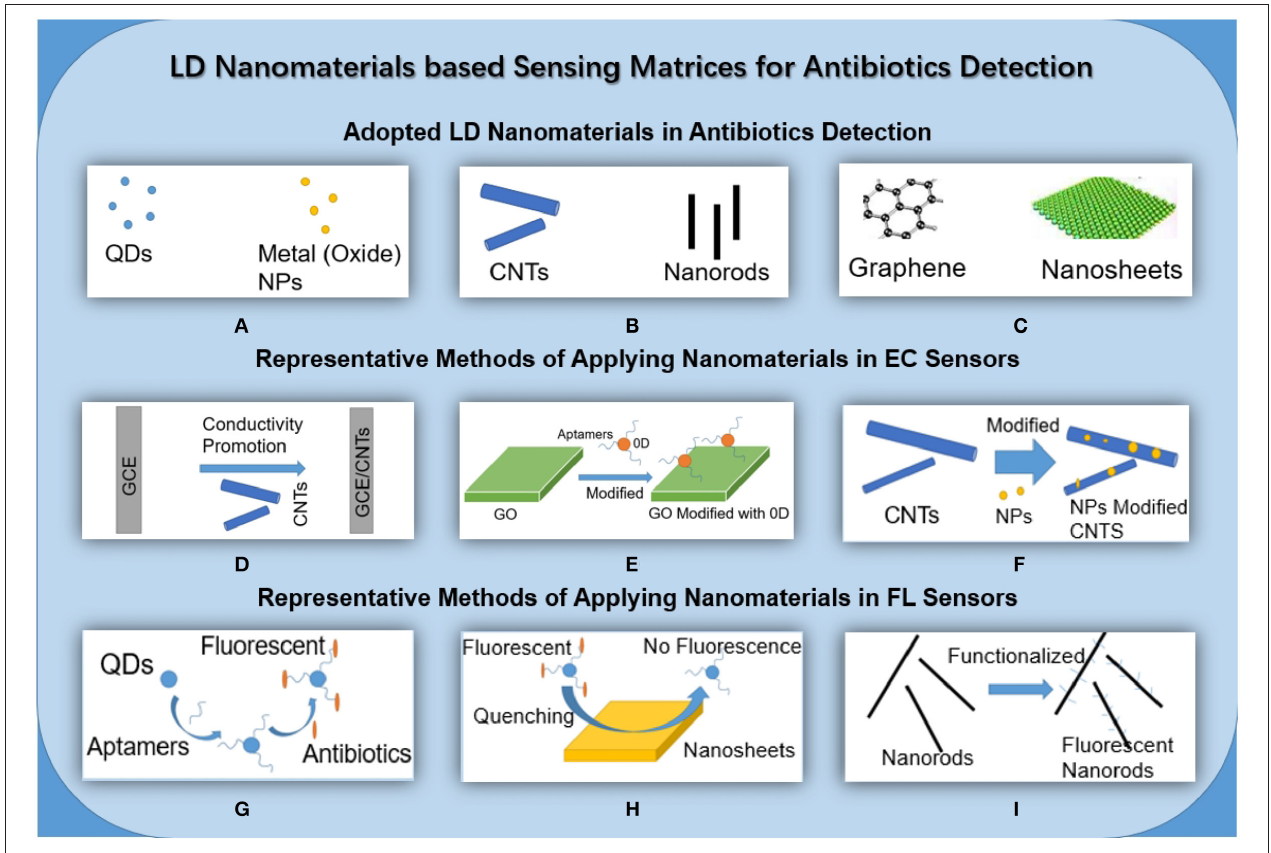
FIGURE 1 | Schematic diagram of LD nanomaterials for EC and FL. (A) . 0D nanomaterials commonly used in the construction of sensors for antibiotic detection. (B) 1D nanomaterials commonly used in the construction of sensors for antibiotic detection. (C) 2D nanomaterials commonly used in the construction of sensors for antibiotic detection. (D) A common strategy for applying nanomaterials in EC sensors: modify the electrode with CNTs to improve electron conductivity. (E) A common strategy for applying nanomaterials in EC sensors: use GO in conjunction with 0D nanomaterials, which improves electrical conductivity, and modify the electrode. (F) A common strategy for applying nanomaterials in EC sensors: use NPs to modify carbon nanotubes and further improve their biocompatibility and conductivity. (G) A common strategy for applying nanomaterials in FL sensors: QDs combined with aptamers and functionalized that recognize specific antibiotics